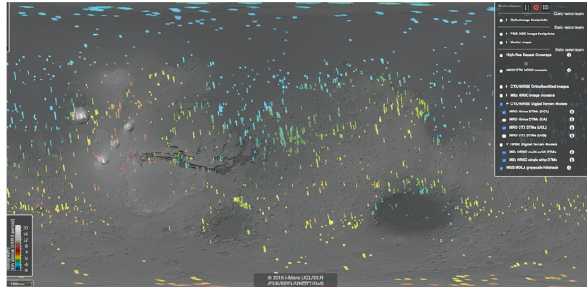
Figure 6. iMars web-GIS [6] showing distribution of 2,375 CTX DTM + ORI products released through the ESA-GSF.